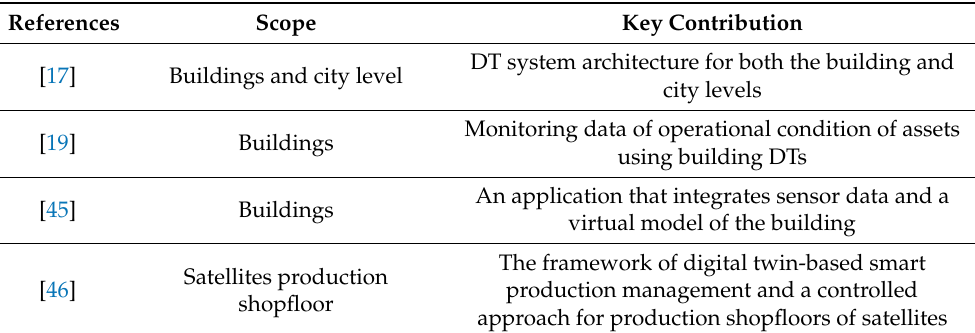
Table 1. Existing DT-Related Studies for Operational and Maintenance (O&M) Arena.